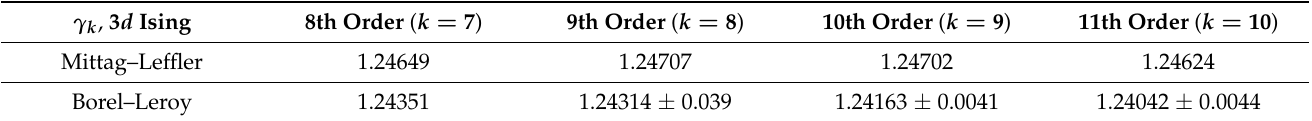
Table 3. Critical Index for the Susceptibility of the Three-Dimensional Ising Model. Dependencies on the approximation order corresponding to the number of coefficients a n employed in the course of